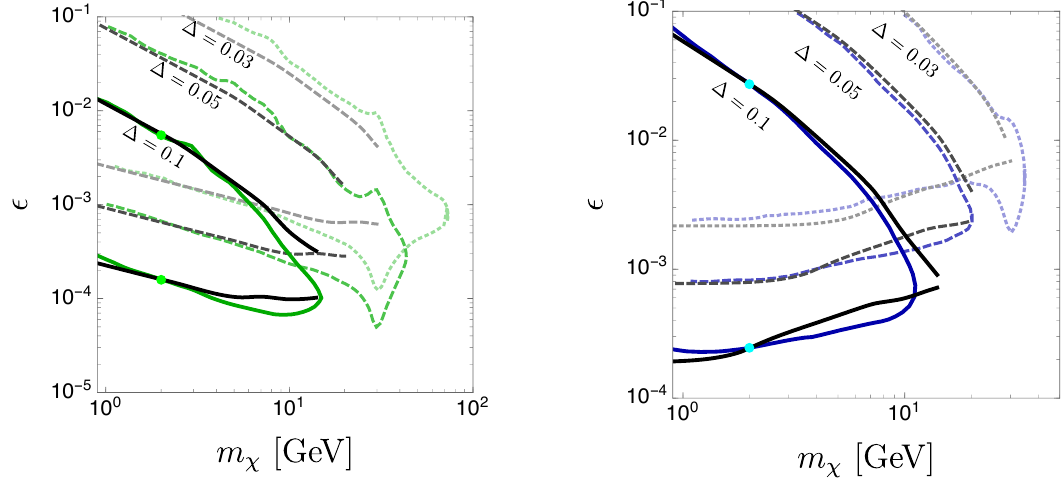
Figure 7 . Our fitting with the results of ref. [146] for MATHUSLA (left) and FASER (right). We take the parameters to be m = 3 m and α 0 = 0 . 1 , which are the same as those in ref. [146]. The A 0 χ mass difference parameter, ∆ , is taken to be ∆ = 0 . 1 (solid), ∆ = 0 . 05 (dashed), and ∆ = 0 . 03 (dotted). The green (blue) lines show the future sensitivities at MATHUSLA (FASER) taken from ref. [146]. The light green (cyan) points in the plot are the reference points of MATHUSLA (FASER) that we have used in the text. The black lines show our approximate sensitivity given by eq. (4.7) and eq.